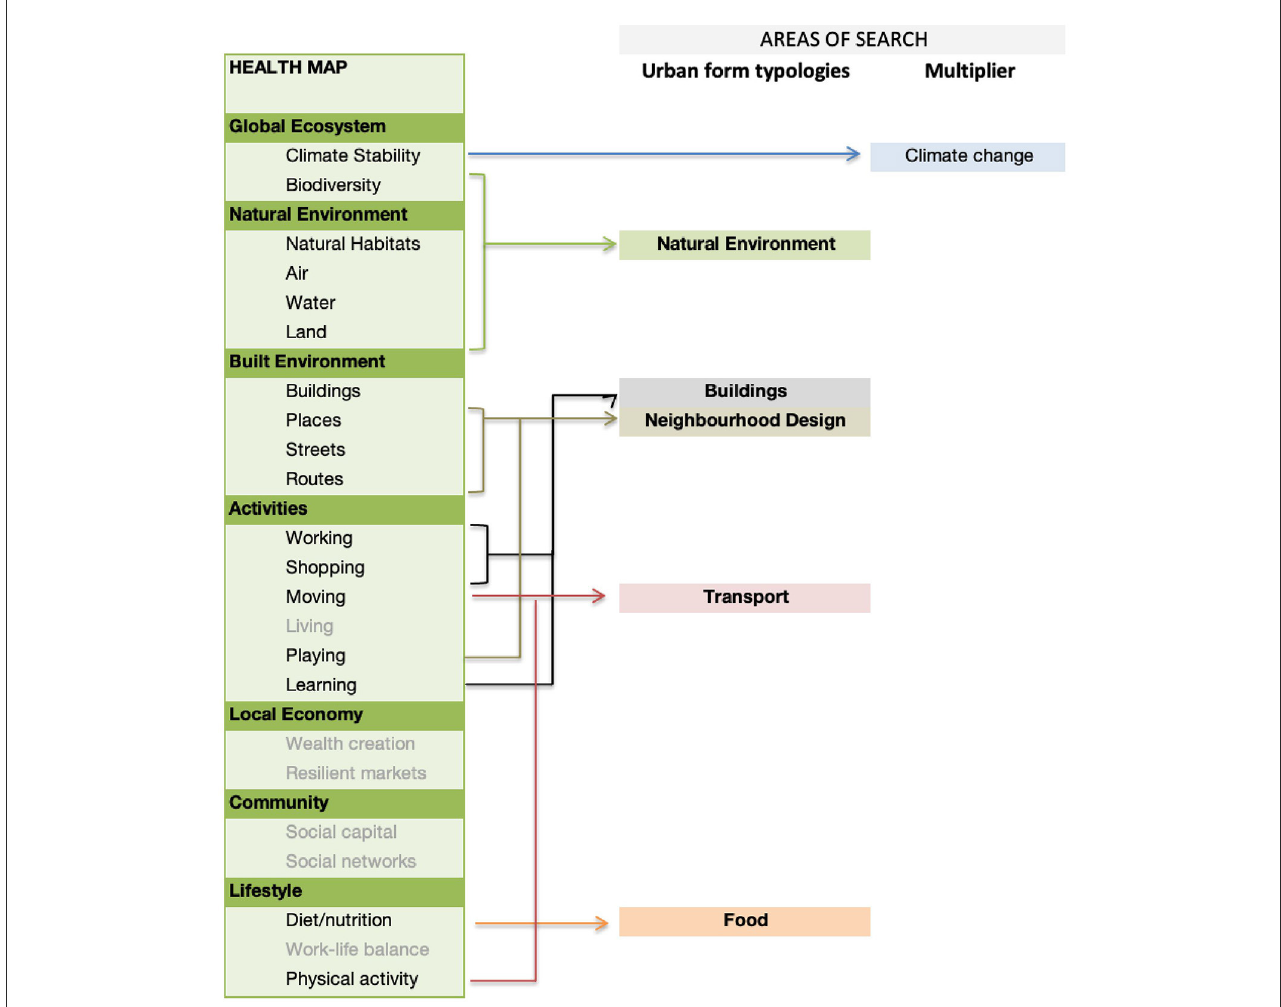
FIGURE1 Identification of five main search areas (of urban form typologies), derived from the Health